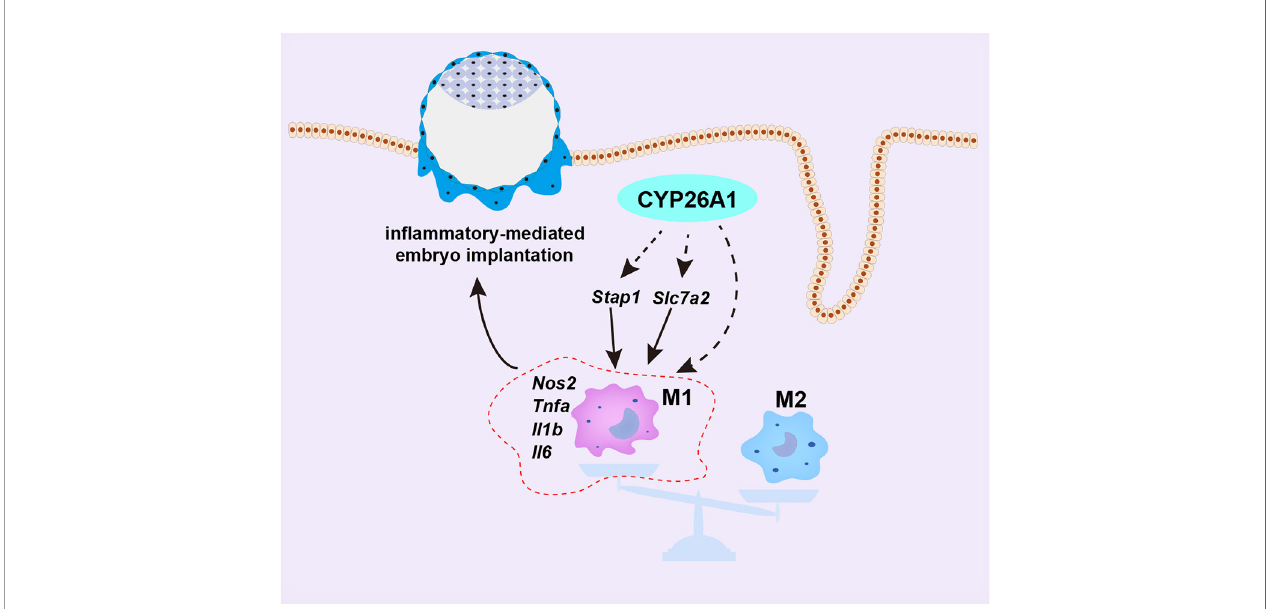
FIGURE 8 | Schematic representation of CYP26A1 affects embryo implantation by regulating uterine macrophage polarization. During the peri-implantation period, CYP26A1 polarizes uterine macrophages towards M1 to provide a certain in fl ammatory response for embryo implantation. Knockdown of CYP26A1 caused insuf fi cient M1 polarization, resulting in insuf fi cient in fl ammation and failed embryo implantation. CYP26A1 may regulate the polarization of uterine macrophages to M1 through Stap1 and Slc7a2